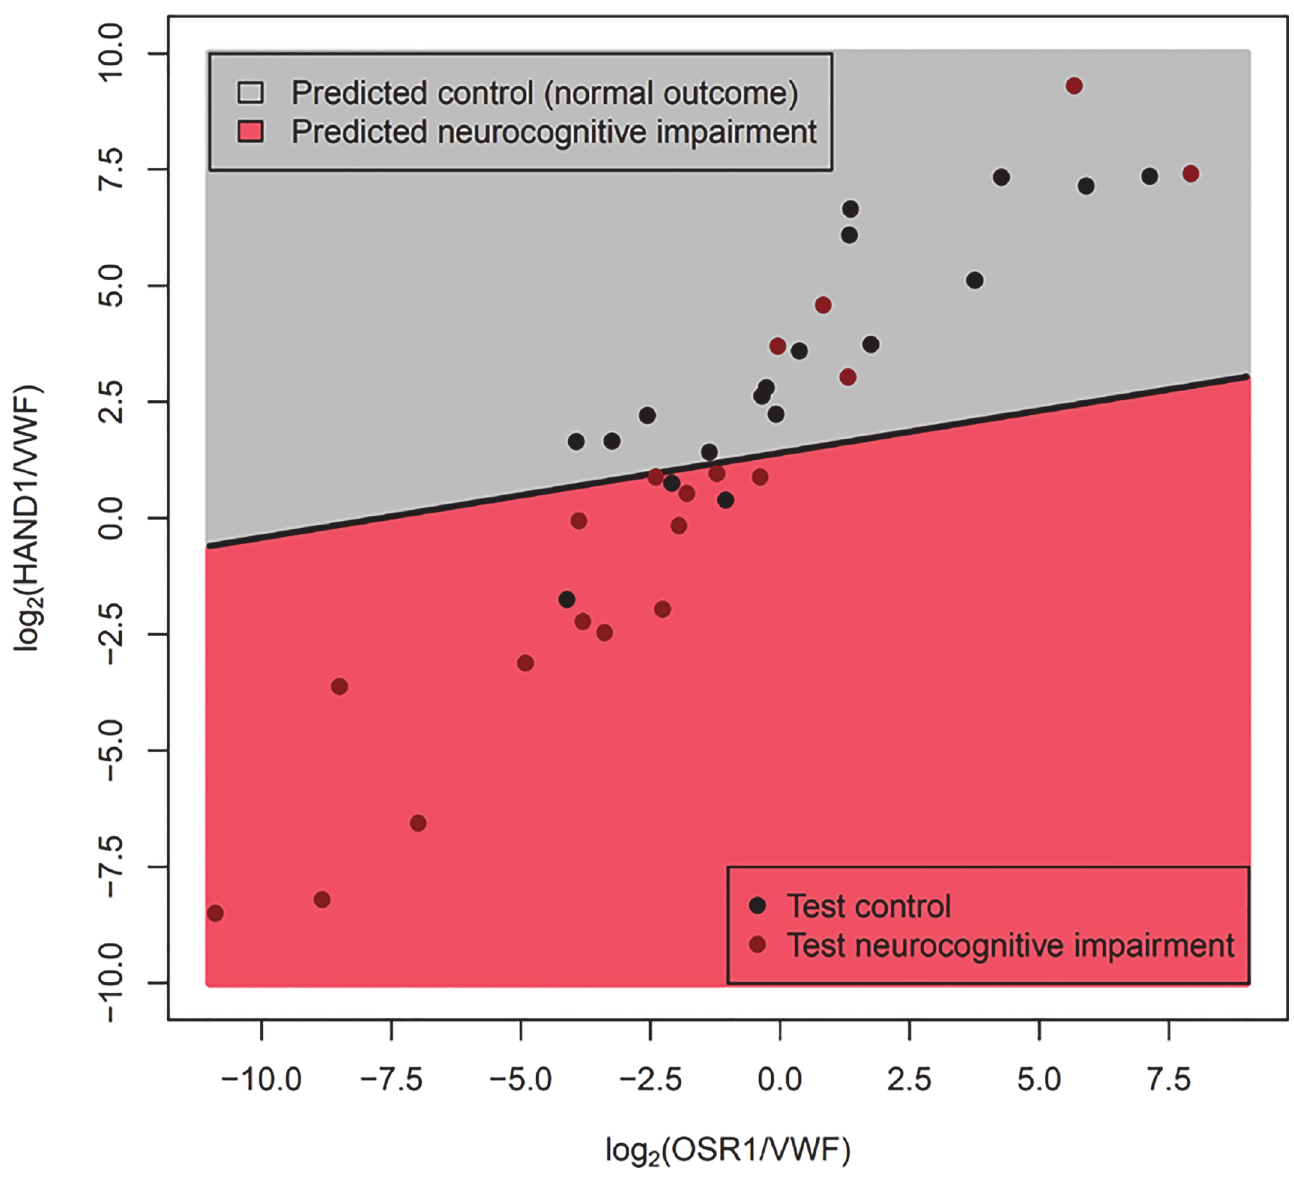
Fig 3. Gene expression-based classifier for neurocognitive impairment using OSR1/VWF and HAND1/VWF expression ratios. The Fig. shows the linear discriminant model (see oblique black line) built using qRT-PCR measured expression data from the training set. Since − Ct values are surrogate for log2 gene abundance, differences in − Ct values of two genes is equivalent to their log 2 expression ratios. Data are represented as log2 expression ratios (y- axis: − Ct HAND1 +Ct VWF ; x-axis: − Ct OSR1 +Ct VWF ). The dots represent data from patients from the test set. The model was tuned on the training data to yield a specificity of * 85%. The actual performance on the test set was sensitivity of 74%, at specificity of